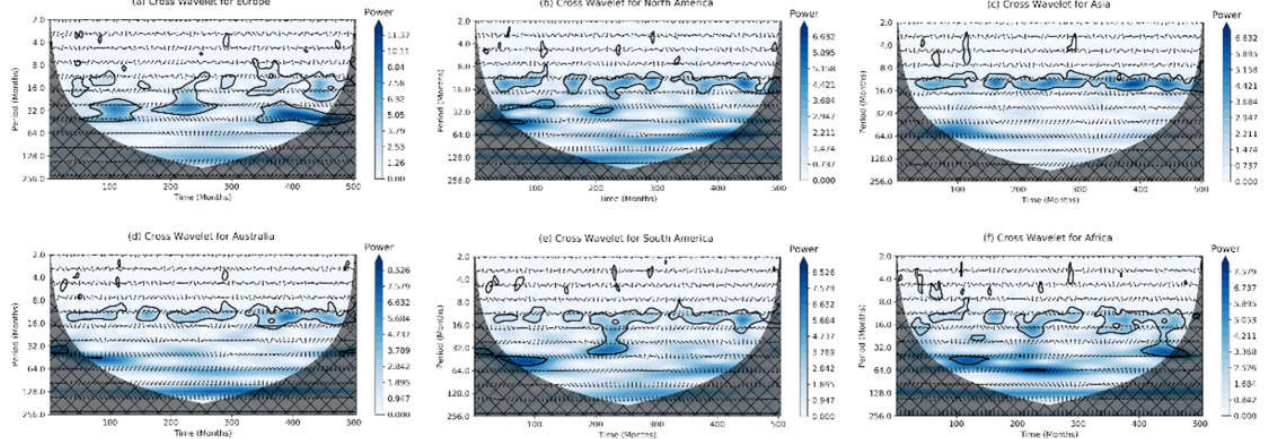
Figure 2. Cross-wavelet power between COL number and Niño-3.4 ONI index in six regions as indicated in Figure 1: ( a ) Europe, ( b ) North America, ( c ) Asia, ( d ) Australia, ( e ) South America, and ( f ) Africa. Colors indicate variance units, contours are 95% confidence level, and vectors the relative phase relationship between the two time series, wherein phase signals point upwards, anti-phase signals point downwards. If Niño-3.4 leads (lags) COL number, arrows point to the right (left). Cross-hatched area indicates the cone of influence, where zero padding has reduced the variance. The time scale (X-axis) refers to the 1979-2020 period.